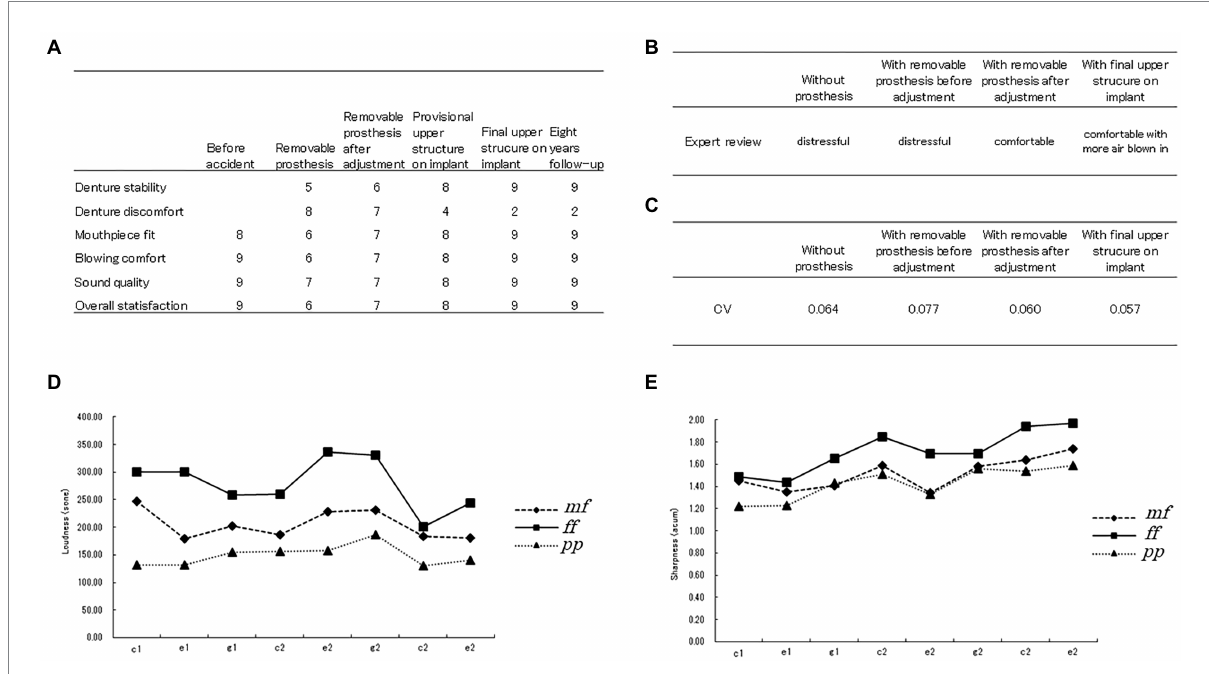
FIGURE 4 Results of this study. (A) Patient’s self-reported rating of satisfaction with her prosthetic rehabilitation and musical performance. (B) Results of the expert review. (C) Coefficient of variation when rhythm analysis was performed at each step of rehabilitation. (D) Results of loudness analysis of notes played by the oboe in three different dynamics. mf, mezzo forte (moderately loud); ff, fortissimo (very loud); pp., pianissimo (very quiet). (E) Result of sharpness analysis of notes played by the oboe in three different dynamics. mf, mezzo forte; ff, fortissimo; pp.,